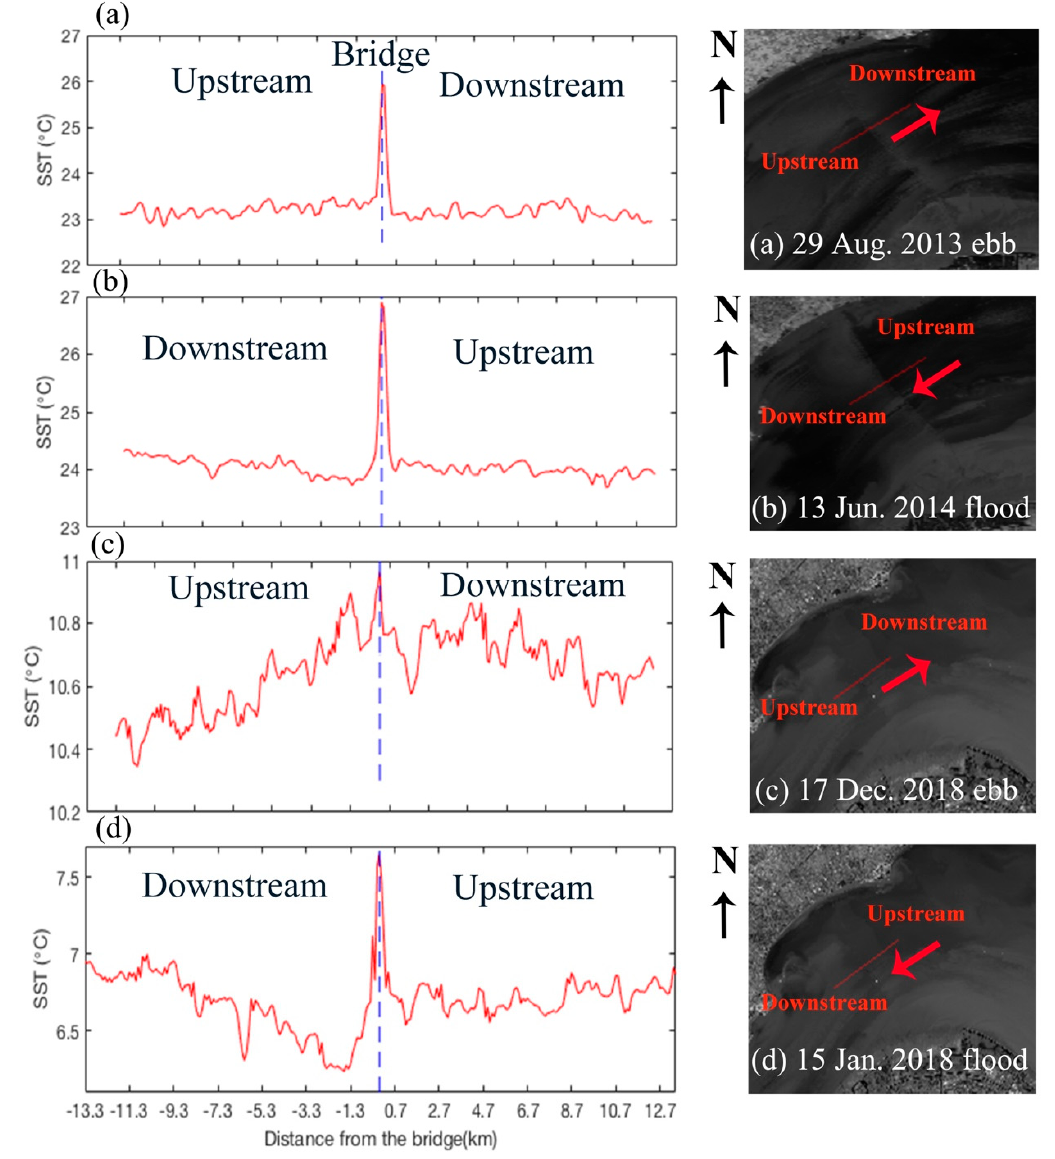
Figure 7. SST along transects obtained from Landsat 8 on 29 August 2013 ( a ), 13 June 2014 ( b ), 17 December 2018 ( c ) and 15 January 2018 ( d ). Vertical blue dashed line denotes the bridge.